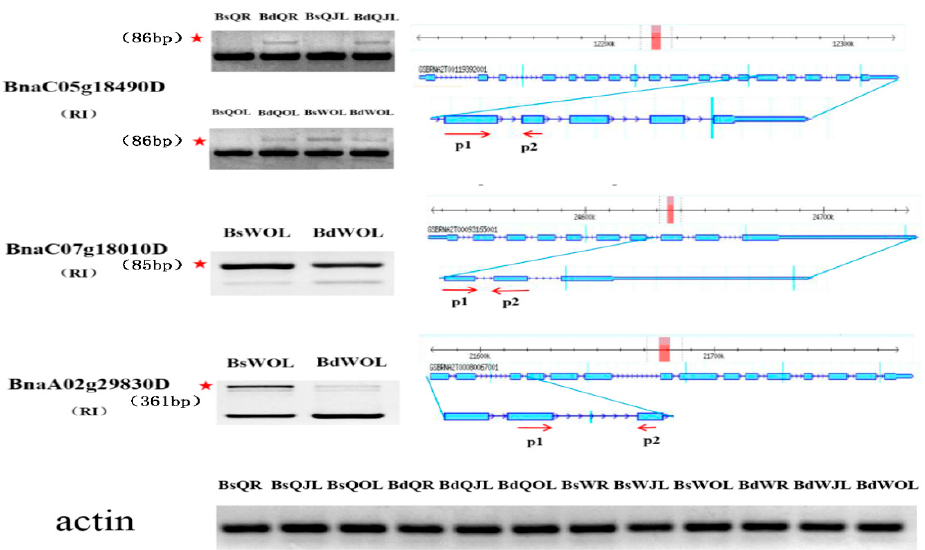
Figure 10. Validation of DAS events in the root, juvenile leaves and old leaves of B. napus cultivars Qingyou10 (QY10) and Westar10 (W10) under boron deficient conditions. The band with the red asterisk showed the fragment generated by the alternative splicing of the gene, which was determined according to the size of the retained intron fragment. The forward and reverse primers, P1 and P2, were designed based on the exon between the retained intron. Bs, boron sufficient condition; Bd, boron deficient condition; QR, root of QY10; QOL, old leaves of QY10; QJL, juvenile leaves of QY10; WR, root of W10; WOL, old leaves of W10; WJL, juvenile leaves of W10. RI, retain